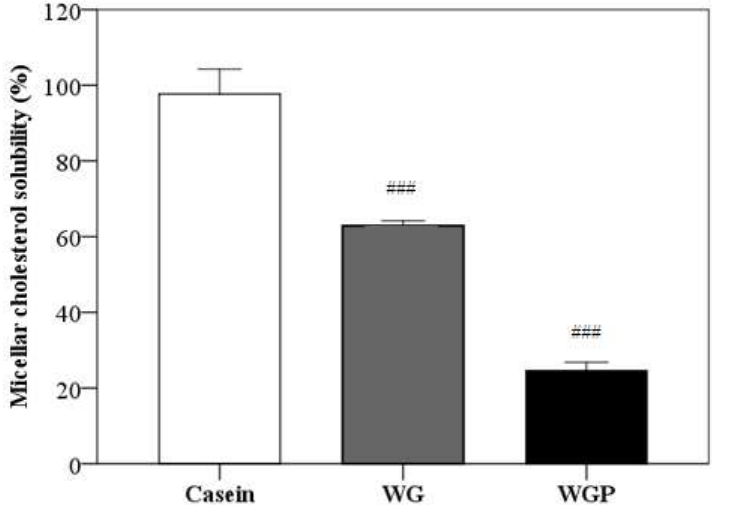
Figure 5. Effects of casein (10 g/L), WG (10 g/L) and WGP (10 g/L) on the micellar solubility of cholesterol in vitro. Values are presented as means ± SEMs ( n = 4). ### p < 0.001 vs. casein.